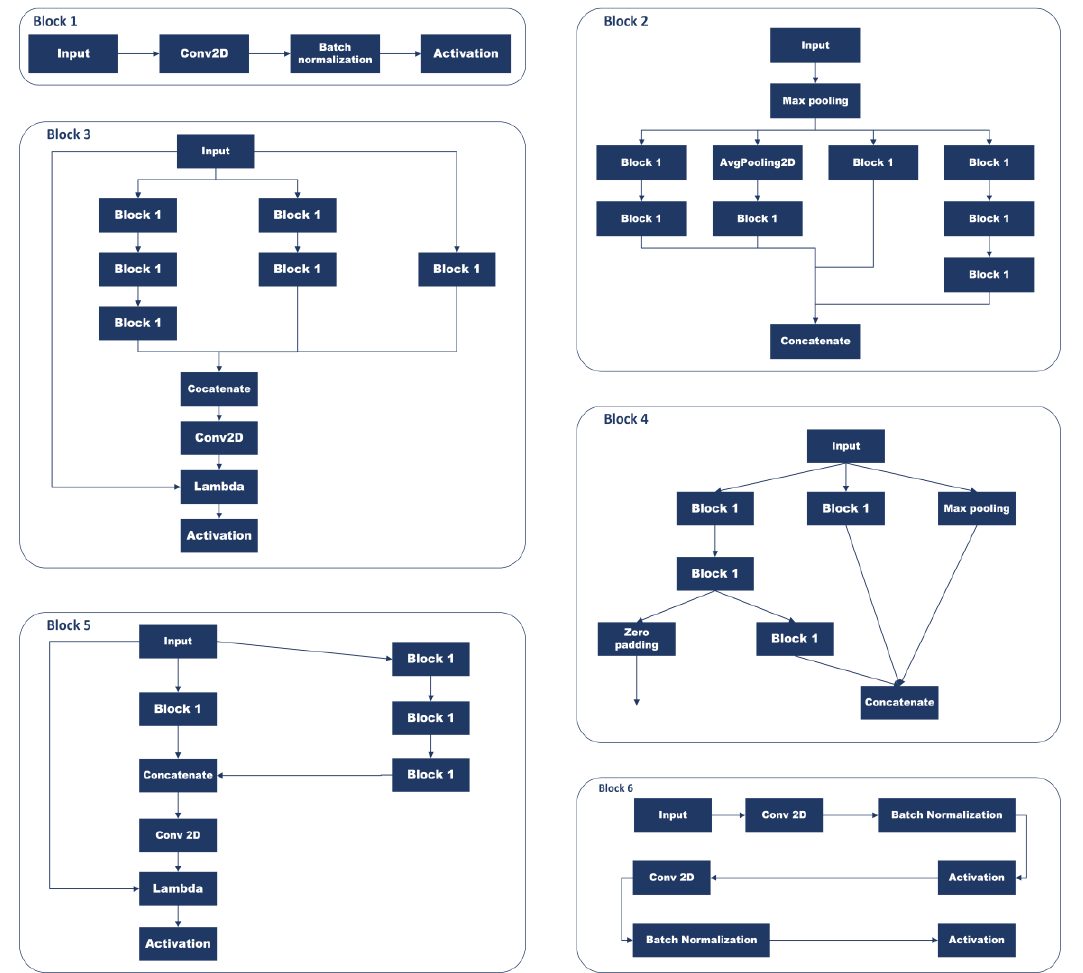
Figure 5. Every block in detail has been used in the ResNet UNet network in Figure 3. Blocks3 and 5 have the residual network and Block 1 in their structure. In architecture, we have one to four parallel convolutions in every block. We use binary classification in this paper, but it can also be used for multi-labeled